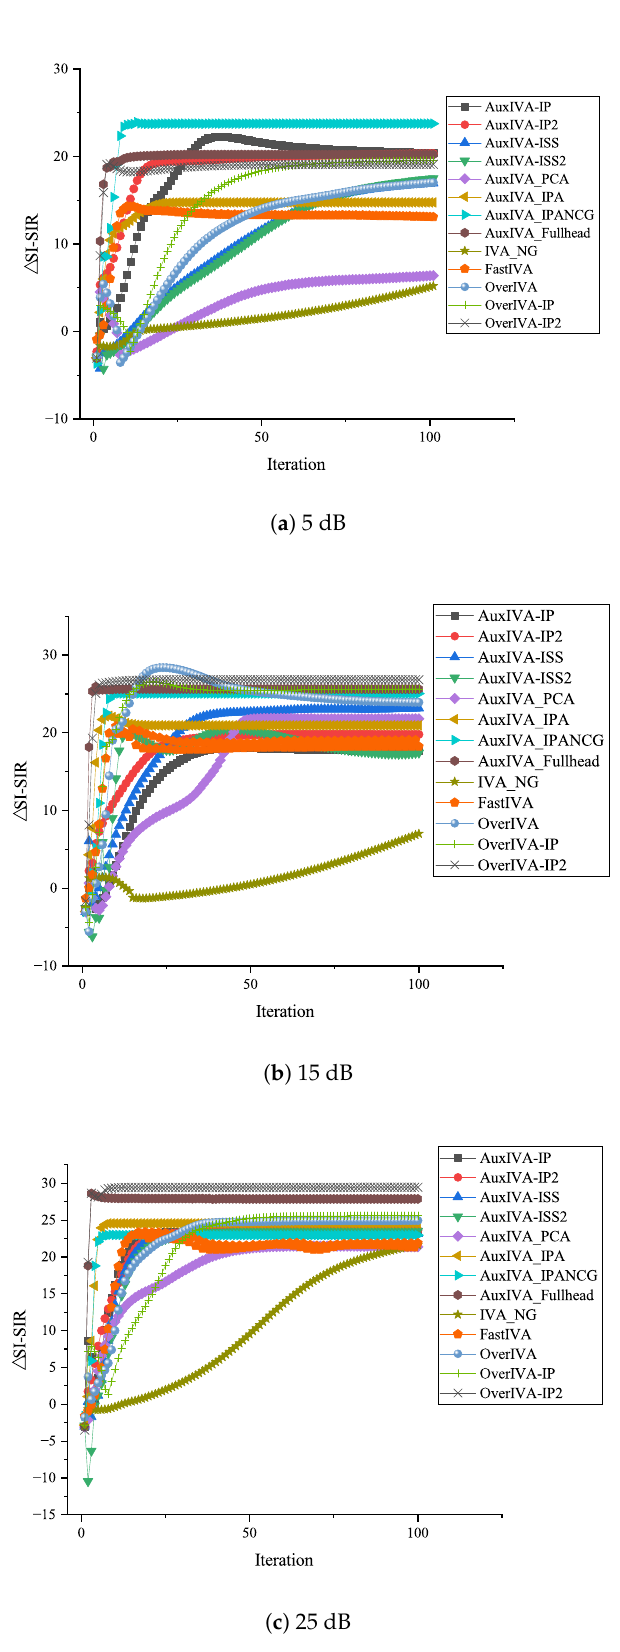
Figure 12. Performance comparison under different SNRs in the 4 × 3 overdetermined